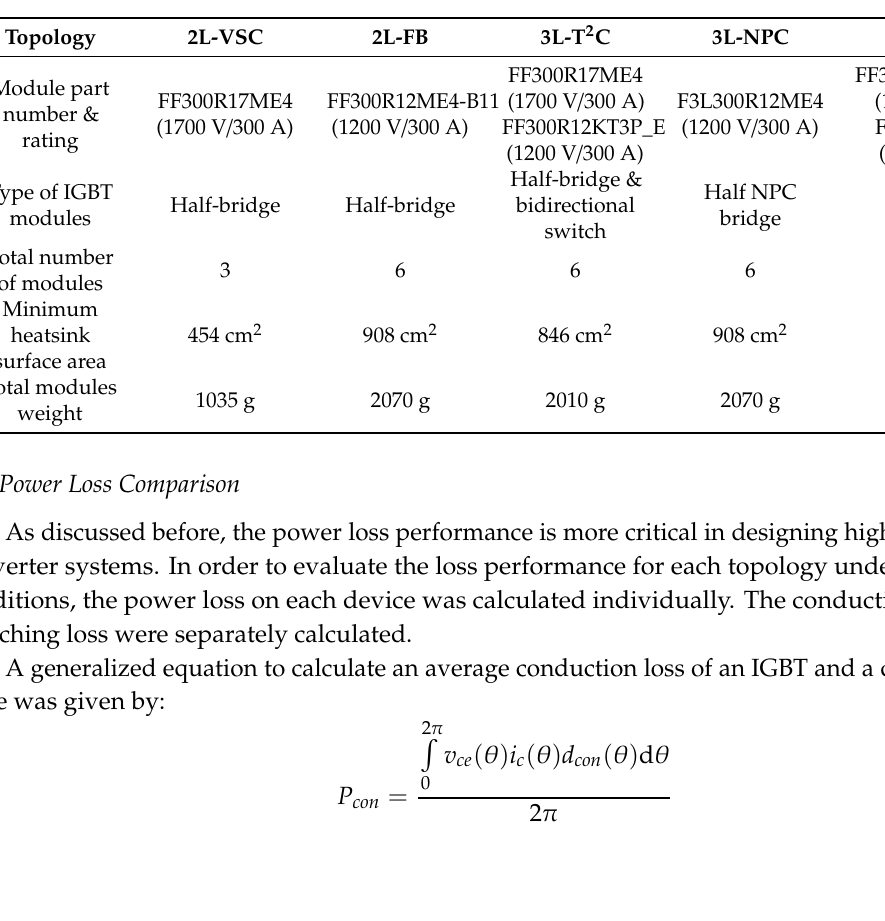
Table 3. Selection and comparison of active components for each candidate